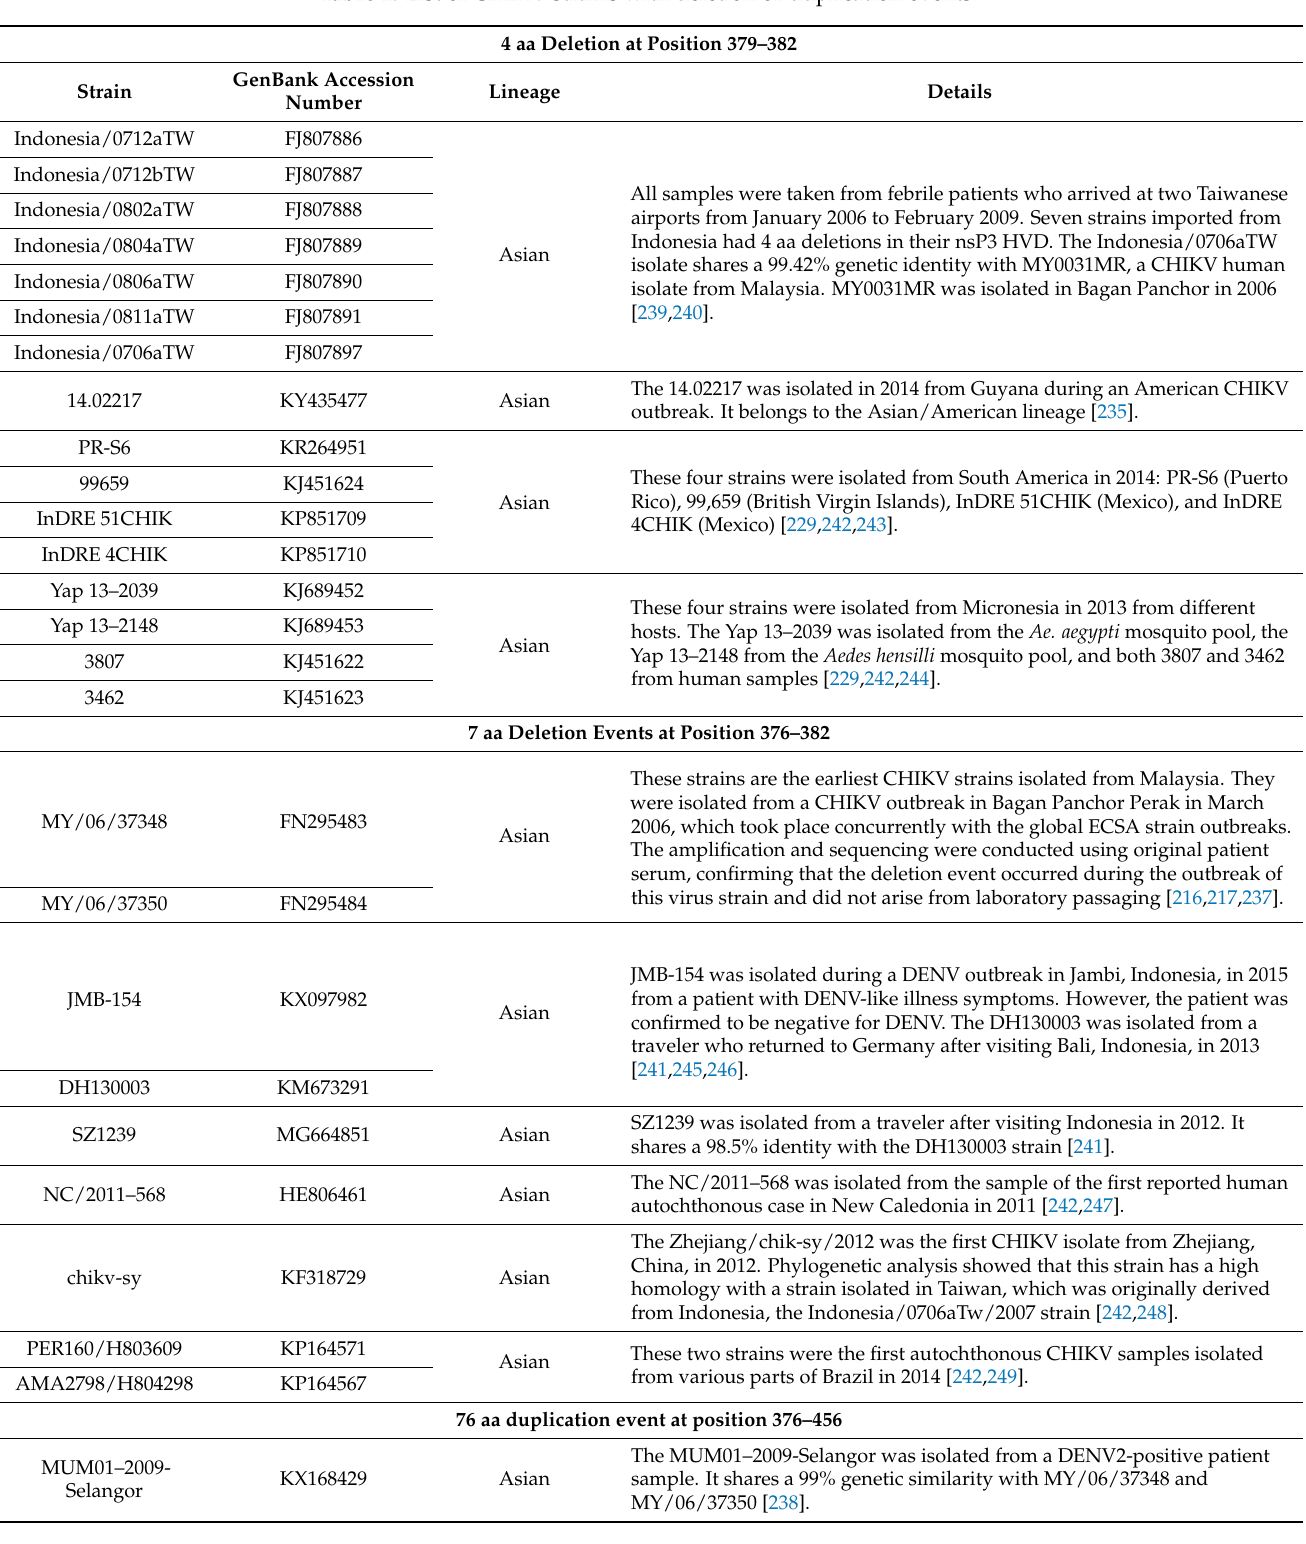
Table 1. List of CHIKV strains with deletion or duplication